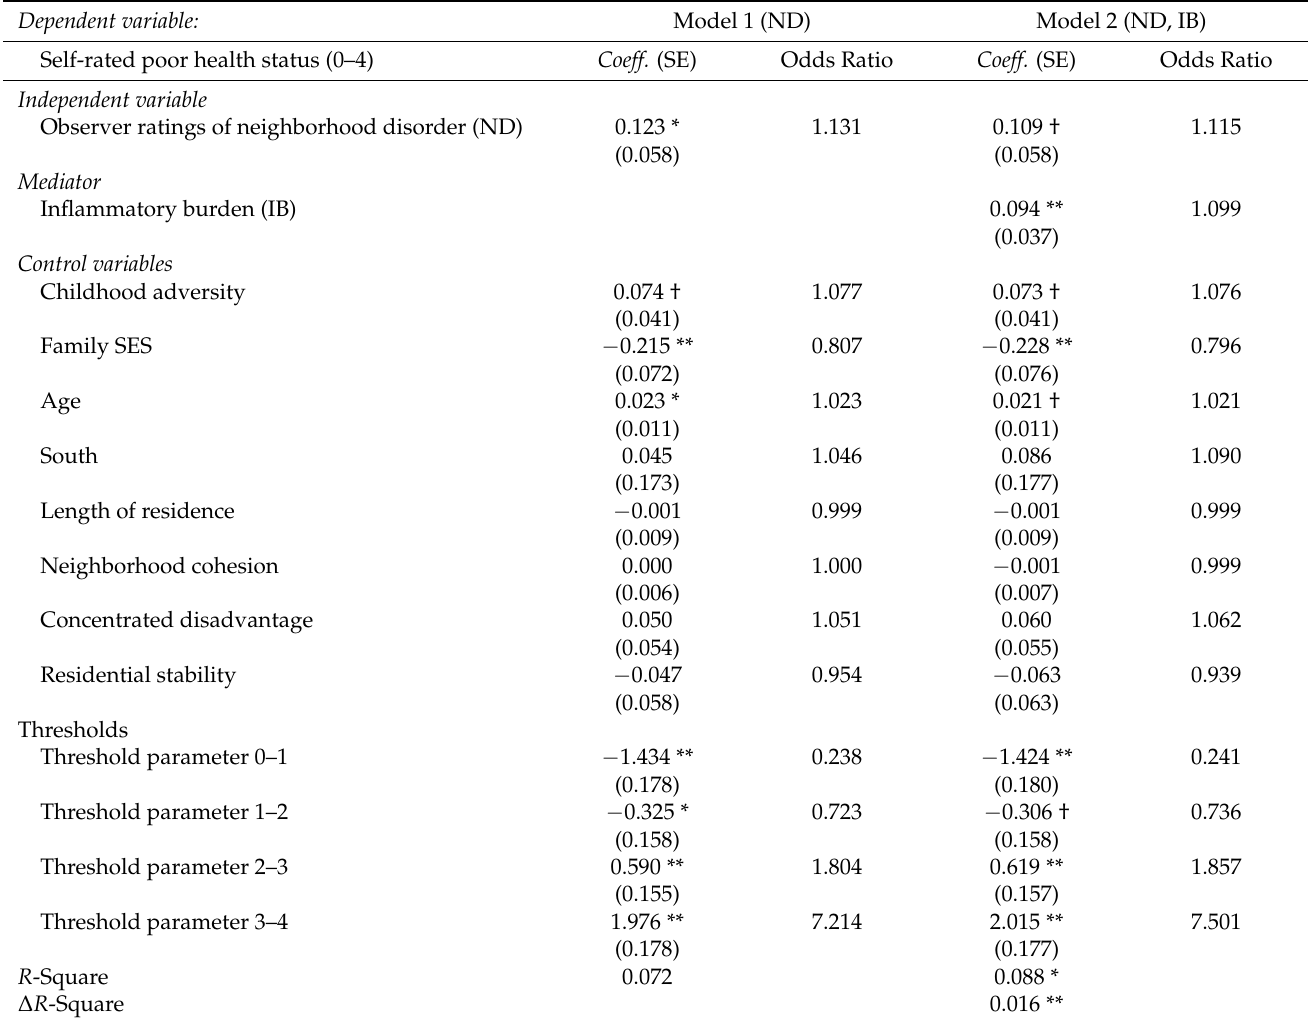
Table 3. Ordered logistic regression of self-rated poor health status on observer ratings of neighborhood disorder and inflammatory